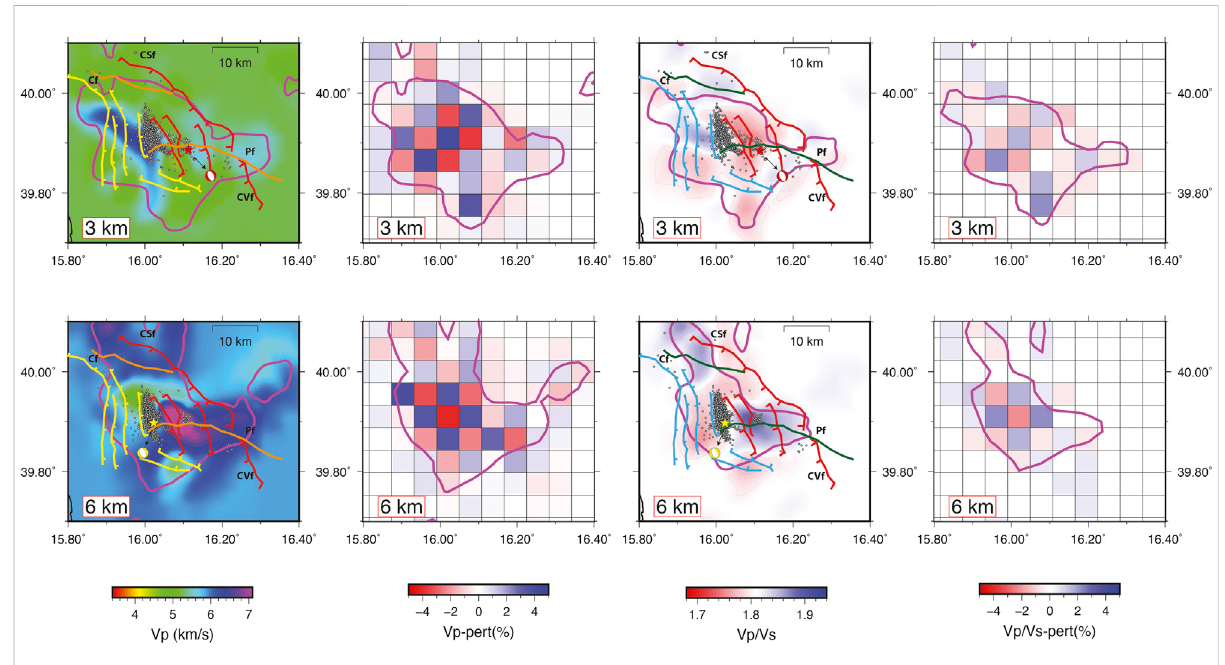
FIGURE 4 P-wave velocity (on the left) and Vp/Vs models (on the right) at the most signi fi cant depths, 3- (on top) and 6 km (on bottom), respectively. Vp andVp/Vsvaluesarecolorcodedaccordingtothecolorscalesatthebottoms;thepurplecontourlinerepresentsthewellresolvedareaineachlayer. Hypocenters of the relocated events are reported in the respective layers as gray dots. The two major earthquakes are represented by red- (28 May 2012, M L = 4.3) and yellow stars (25 October 2012, M L = 5), respectively, together with their focal solution (http://cnt.rm.ingv.it/tdmt.html; Scognamiglio et al., 2009). Major active faults, as for Figure 1, are also reported on each layer, as colored line segments (on the Vp tomograms only, colors of the fault traces have been modi fi ed with respect to Figure 1, to make them more visible). For each layer (both Vp and Vp/Vs models), the corresponding results of the checkerboard test are shown on the right of each